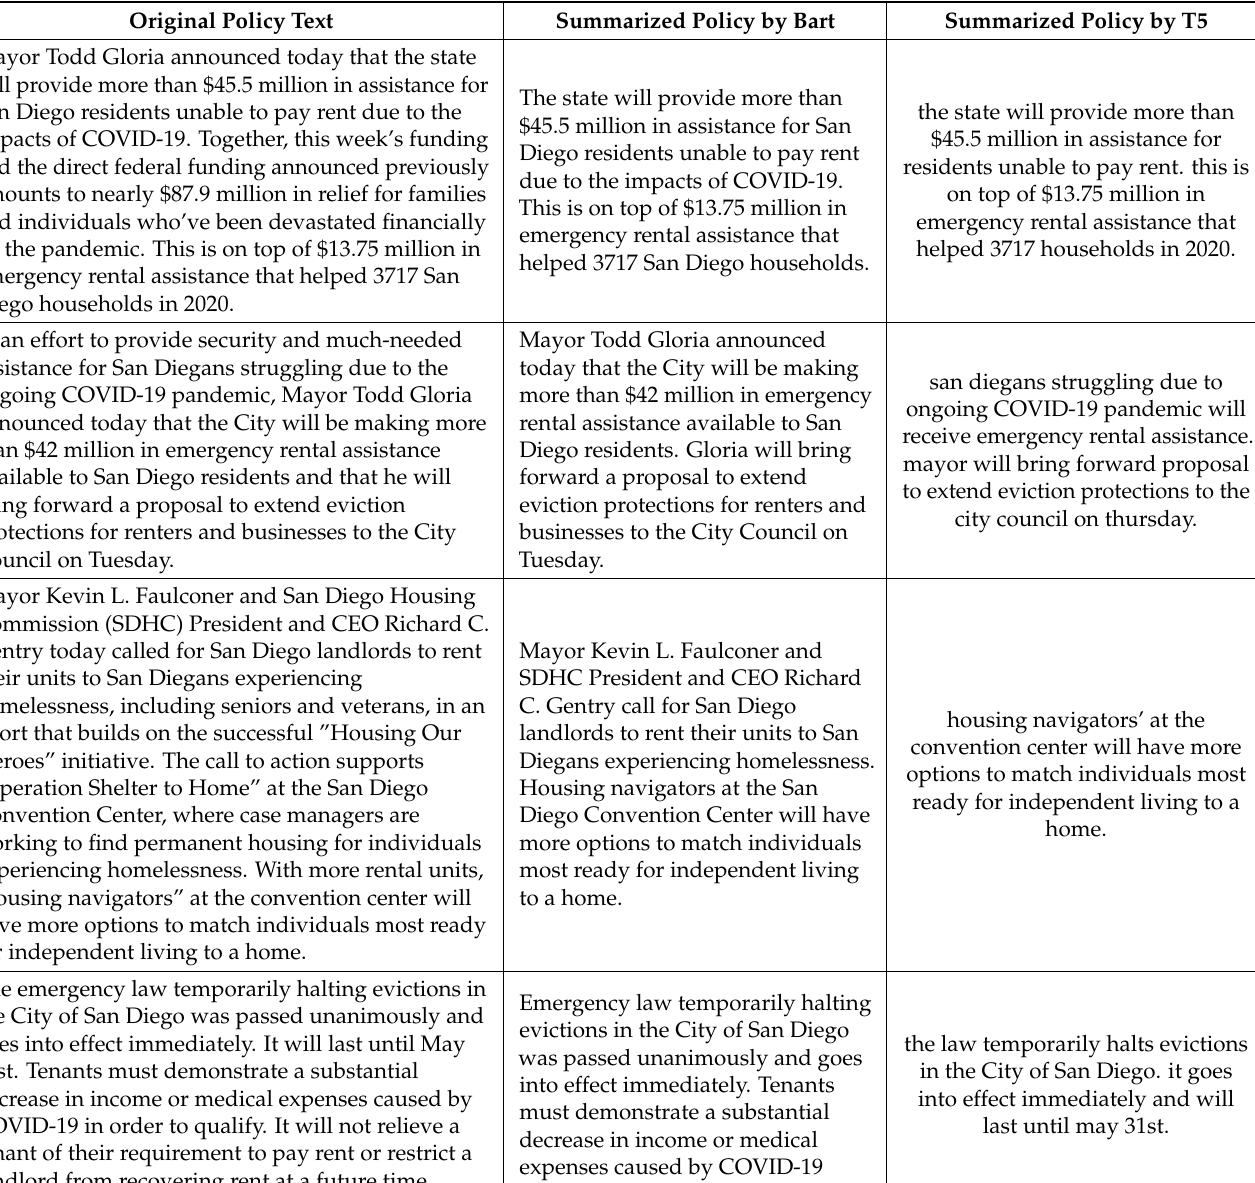
Table 7. Policy Summarization Results with Original Policy